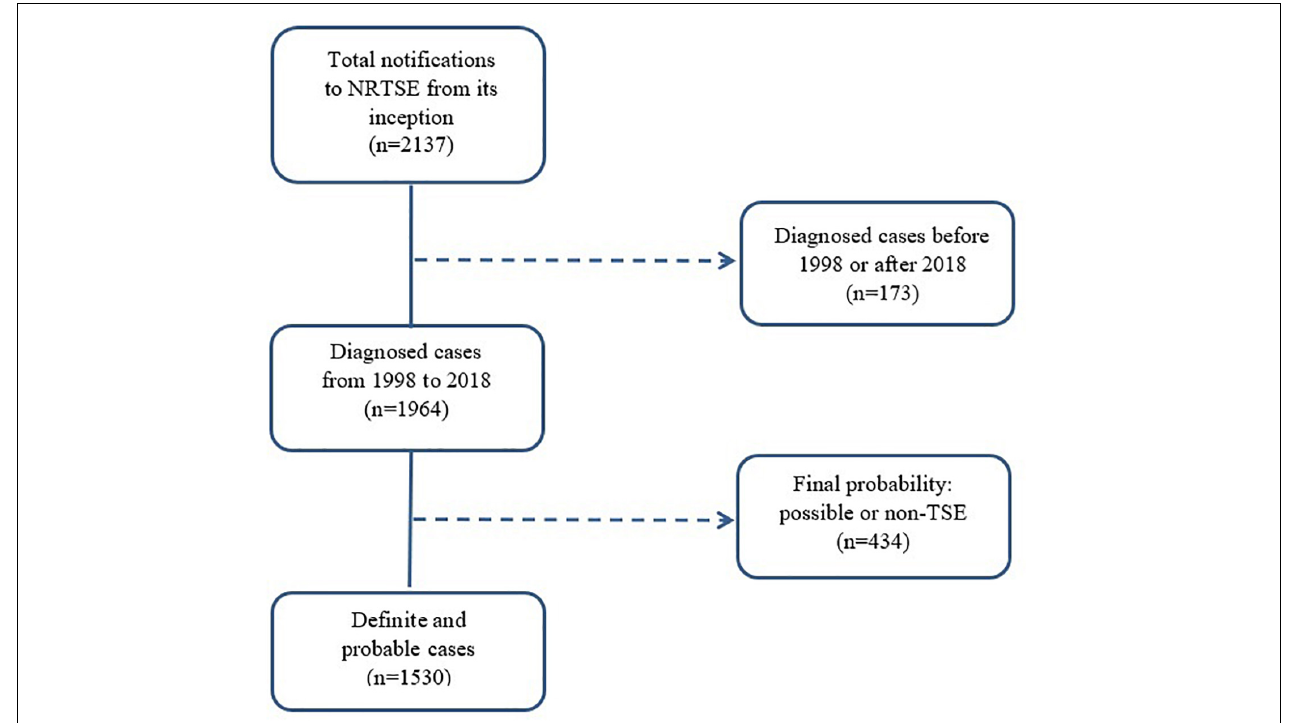
FIGURE 1 | Flow chart showing case-selection for study purposes. NRTSE, National Register of Human Transmissible Spongiform Encephalopathies; TSE, Transmissible Spongiform